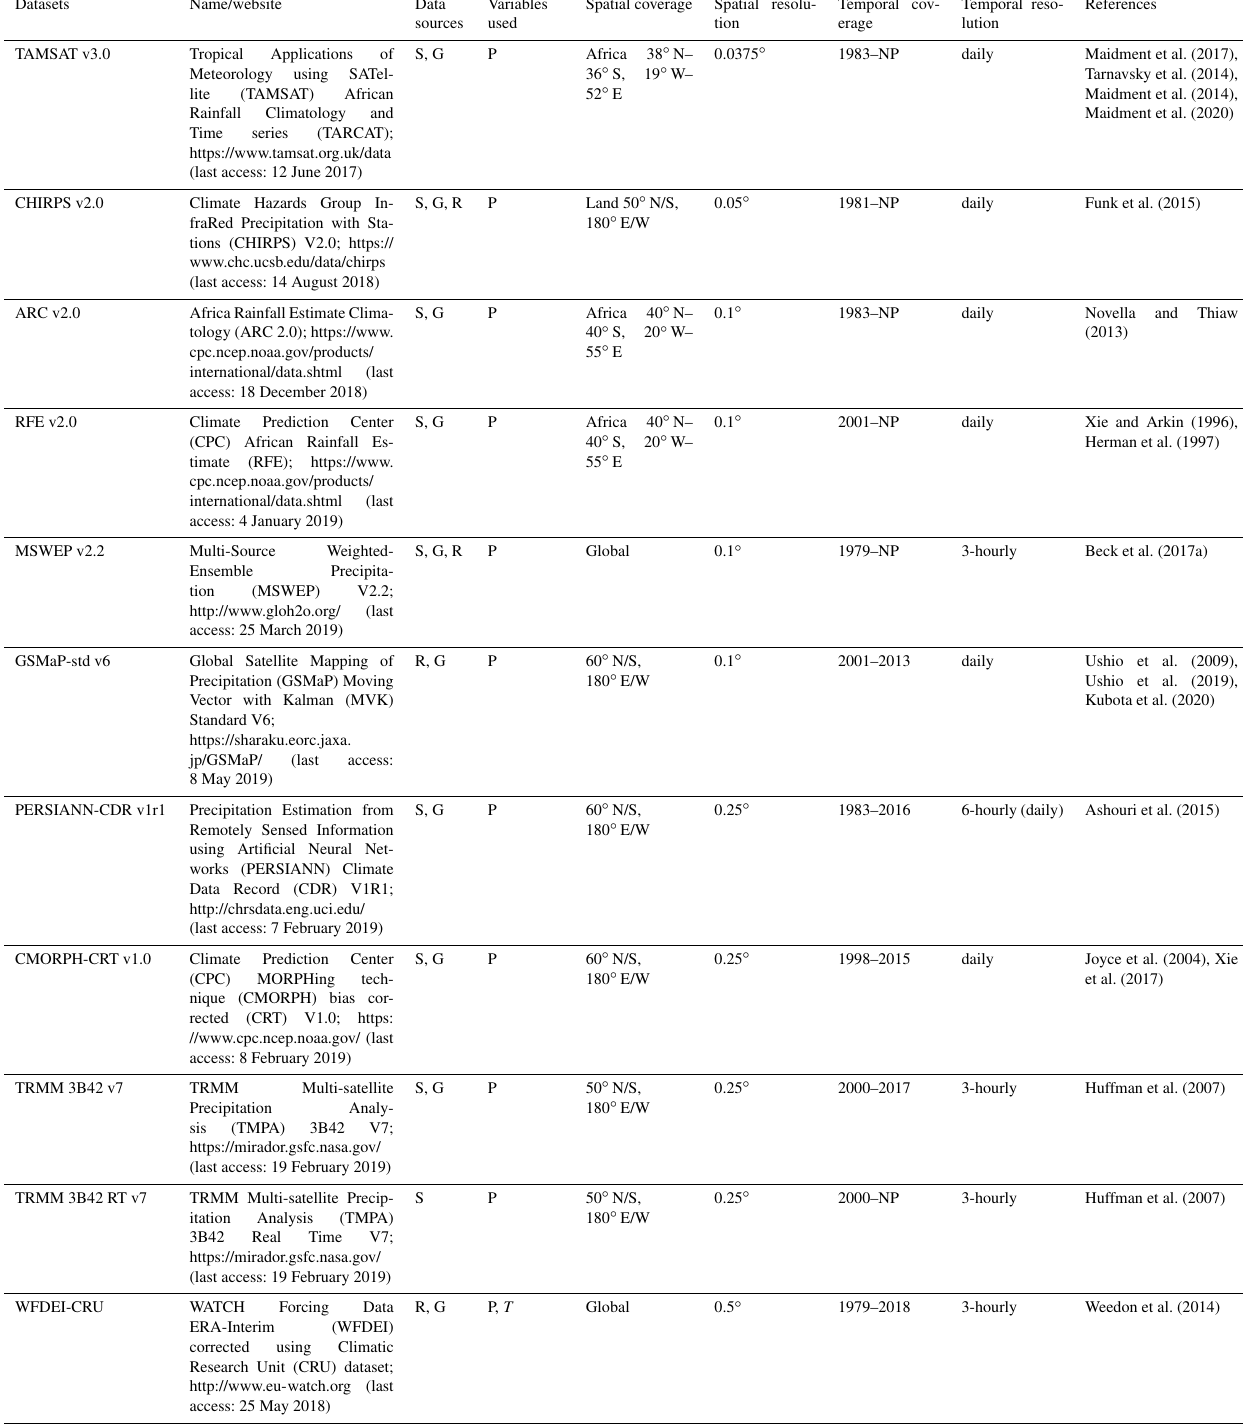
Table 1. Meteorological datasets with spatial resolution used; the table presents the characteristics of the datasets used in this study, although different spatial and temporal resolutions can be available from the data providers. G: gauge; S: satellite; R: reanalysis; P: precipitation; T : temperature; NP: near